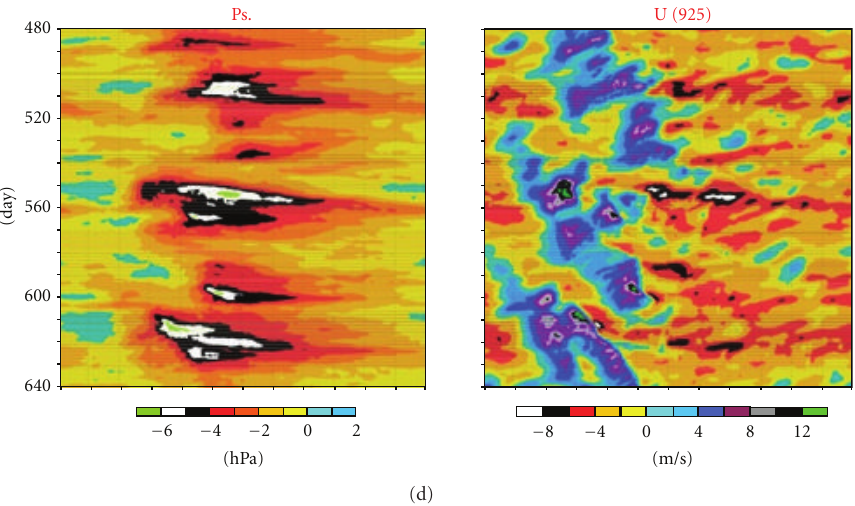
Figure 14: (a) Longitude-time sections of the upper-level (200hPa) cloud water mixing ratio, and relative humidity at 700hPa, (b) a measure of buoyancy (in unit of temperature) which the air rising from the boundary layer (about 750 m height) acquires at 700hPa, and relative humidity at 900 hPa, (c) the low-level rainwater mixing ratio, and temperature anomaly at the lowest level of the model ( P B = 996 hPa), and (d) surface pressure and the zonal velocity at 925 hPa in case (R). The period corresponds to that in Figure 7, but the values are averaged for